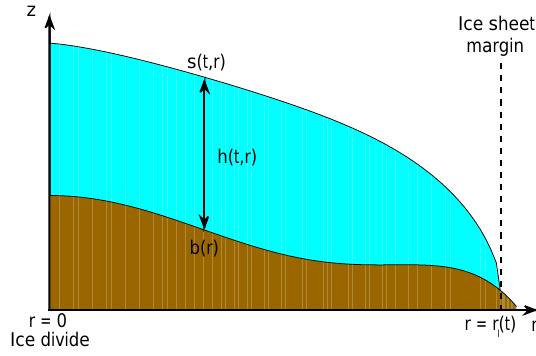
Figure 1. Section of a grounded radially symmetrical ice sheet. Table 1. Parameters involved in the computation of the vertically averaged horizontal component of the ice velocity (Eq.